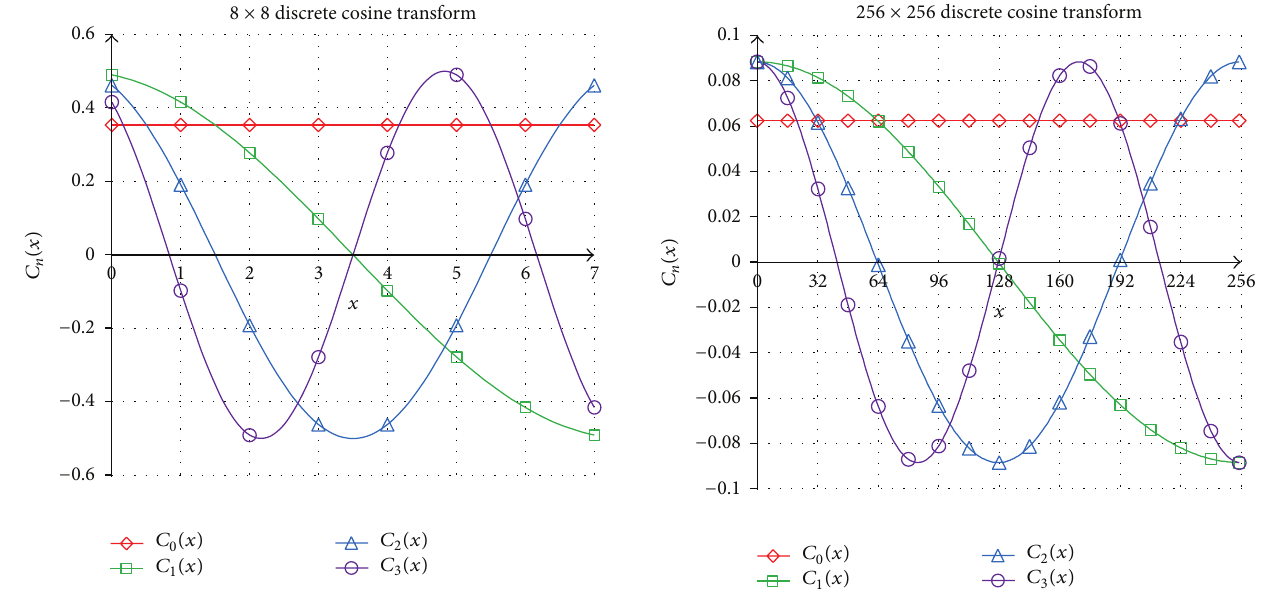
Figure 2: The first four 8 × 8 DCT of set 𝐶 𝑛 (𝑥) for 𝑛 = 0, 1, 2,3 .